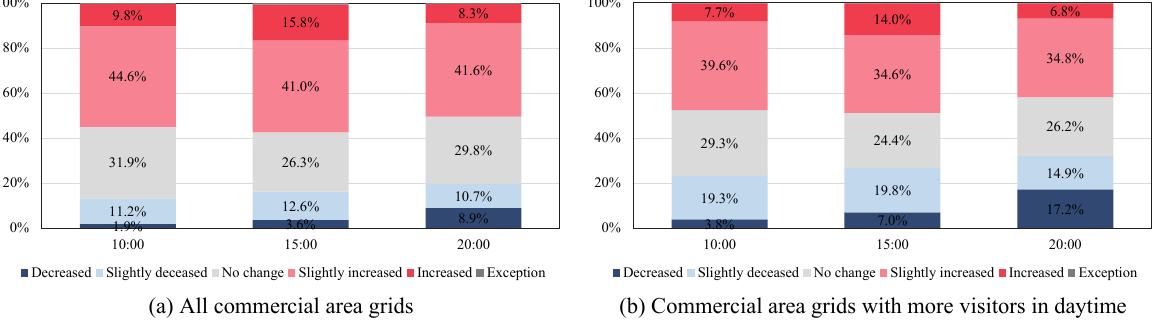
(a) All commercial area grids (b) Commercial area grids with more visitors in daytime Figure 7 . Proportion of clusters by time slots